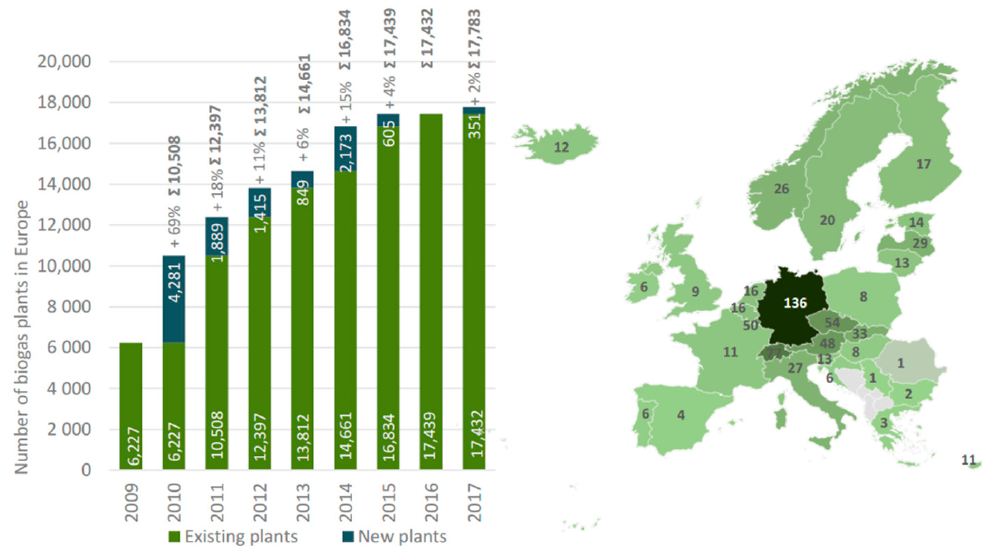
Figure 1. ( a ) Change in the number of biogas plants in Europe. ( b ) Distribution of biogas plants per 1 million people